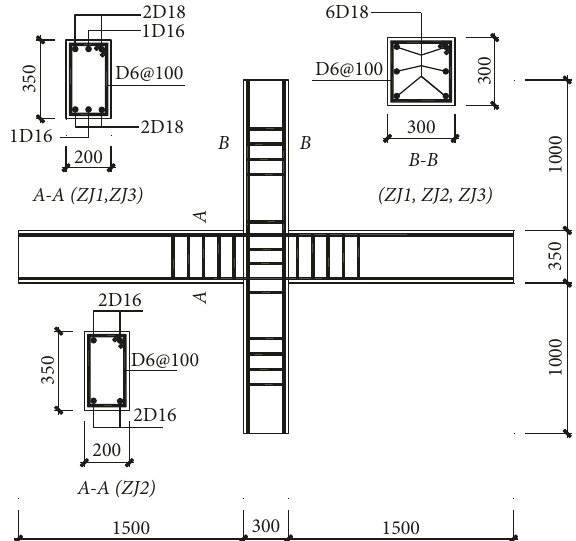
Figure 1: Specimens dimension and